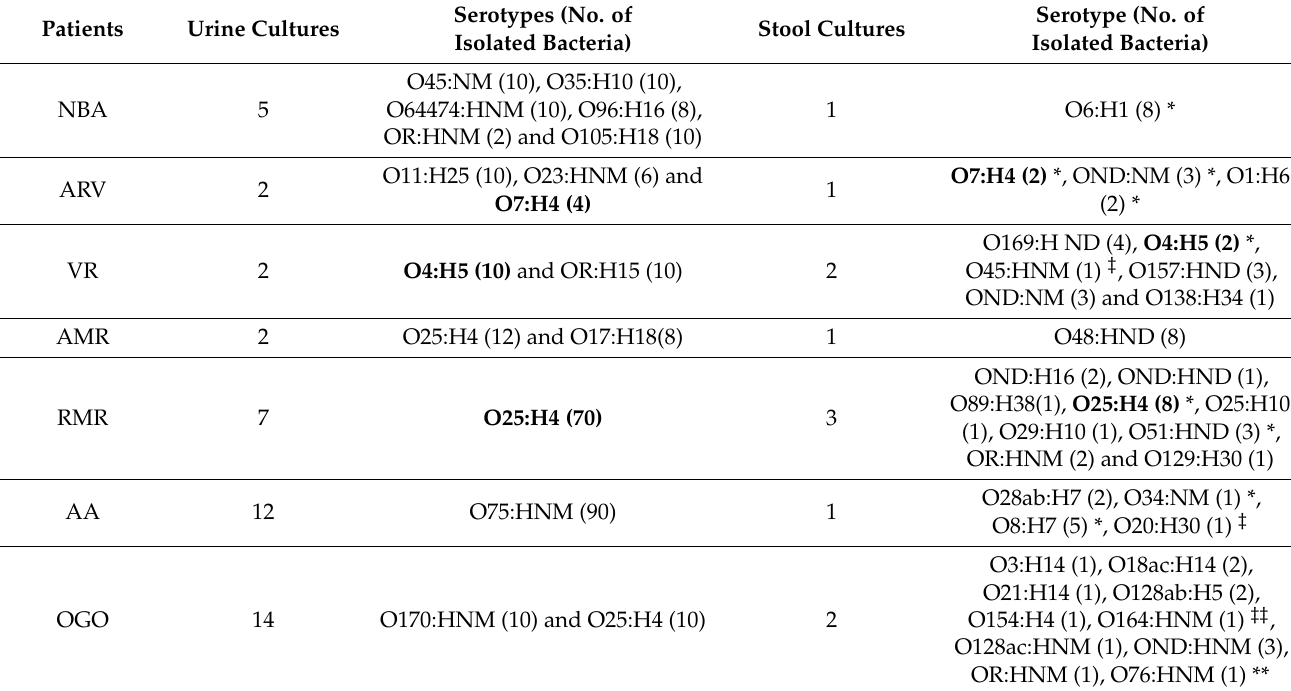
The serotypes identified in urine and feces in the same patient are indicated in bold. ND: Serotype not included in the typing scheme. NM: Non motile, HND: Flagellar antigen (H) Non-Determined with the 56-serum tested. * UPEC serotype, ** EPEC serotype, ‡ EAEC serotype, ‡‡ EIEC